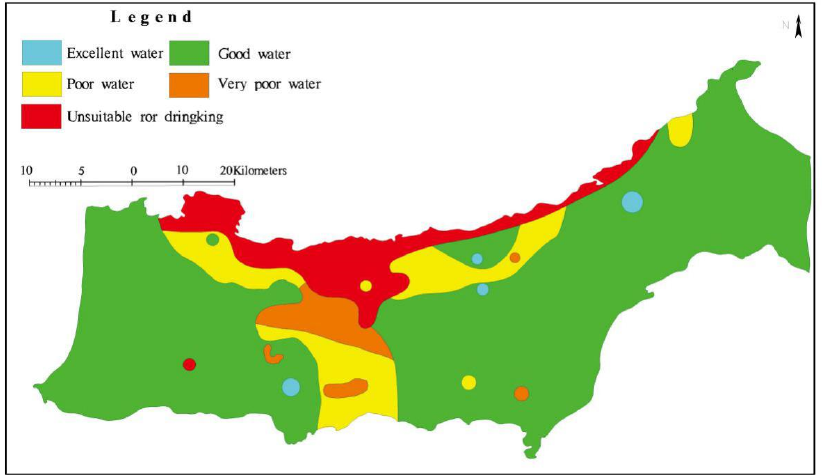
Figure 7. A map showing the suitability of groundwater for drinking within the Jinta Basin, China as according to the water quality index (WQI).